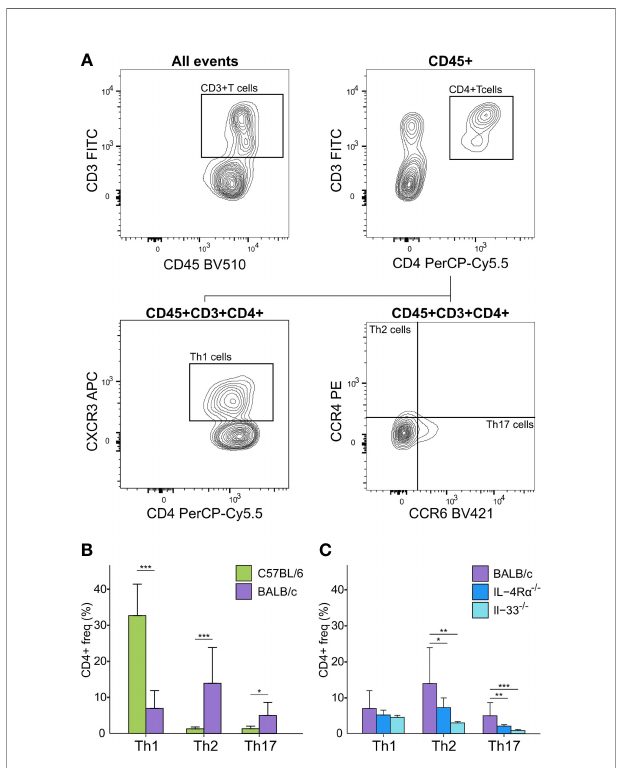
FIGURE 3 | Flow cytometry analysis of Th cell subsets in blood of naïve immunocompetent and immunode fi cient mice show immune polarizations. (A) Flow cytometry gating strategy for T-cells (CD45+/CD3+/CD4+) further distinguished as Th1 (CXCR3+/CCR4-), Th2 (CCR4+/CCR6-), and Th17 (CCR6+/CCR4-) cells. (B) C57BL/6 animals (green, n = 16) are Th1-polarized whereas BALB/c (purple, n = 12) are Th2 polarized, and show signi fi cantly higher Th17 cells compared to C57BL/6. (C) BALB/c mice also showed a Th2 polarization compared to both IL-4R a -/- (blue, n = 16) and IL-33 -/- (light blue, n = 7) mice that also showed signi fi cantly higher levels of Th17 cells compared to knock-out mice. No T-cells were observed for NSG mice. * P < 0.05. ** P < 0.01. *** P <